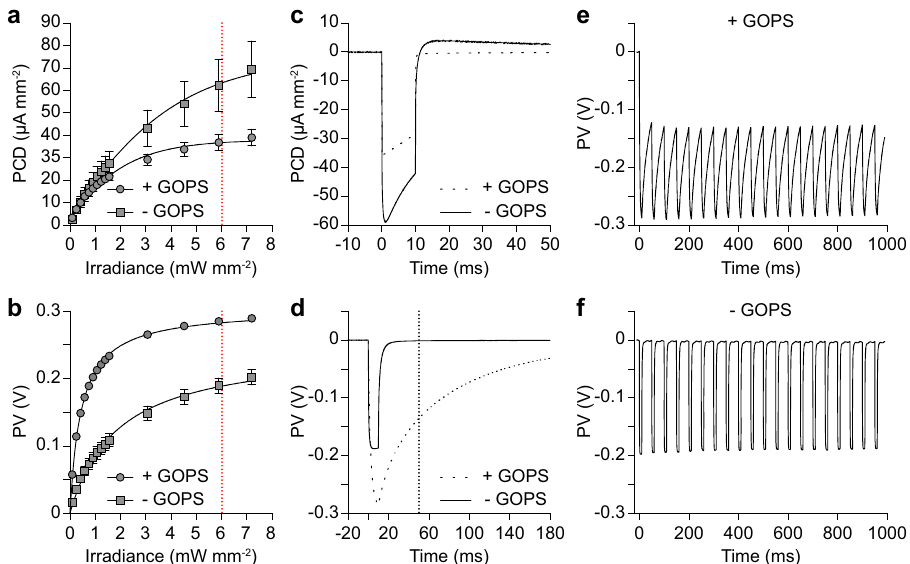
Fig. 4 Optoelectronic responses with GOPS. a , b Mean (±s.e.m.) PCD ( a ) and PV ( b ) obtained with pristine PH1000/PCPDTBT:PC 60 BM/Ti (grey squares, n = 4) and PH1000/PCPDTBT:PC n = 3) at 730nm. The solid lines are the interpolations with an 60 BM/Ti supplemented with 1 v/v% GOPS (grey circles, asymmetrical, fi ve-parameter, logistic dose-response function for PCDs and a hyperbola function for PVs. The vertical red dotted lines represent the normalized irradiance for 730nm (6mWmm − 2 ). c , d Grand-average PCD ( c ) and PV ( d ) traces obtained upon 10-ms pulses (730 nm, 6 mWmm − 2 ) with pristine PH1000 (solid line, n = 4) and PH1000 with GOPS (dashed line, n = 3). The vertical dotted line in d shows the PV value 50 ms after the light onset. e , f Representative traces from single electrodes of PV upon the delivery of a train stimulation composed of 20 pulses (10ms, 730nm, 6 mW mm − 2 ) delivered at 20Hz with pristine PH1000 ( f ) and PH1000 with 1 v/v% of GOPS ( e